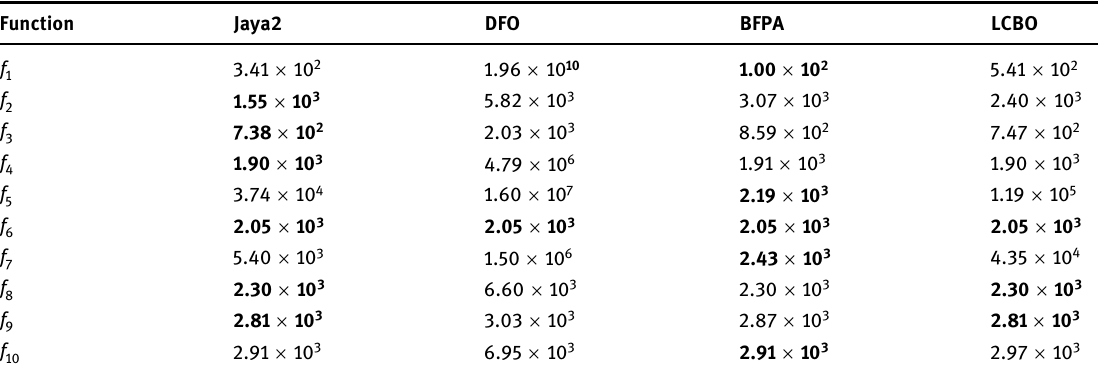
Table A3: The CEC 2020 ( = D 20 ) median function values achieved by Jaya2, DFO, BFPA, and LCBO over 30 runs and 200,000 function evaluations Function